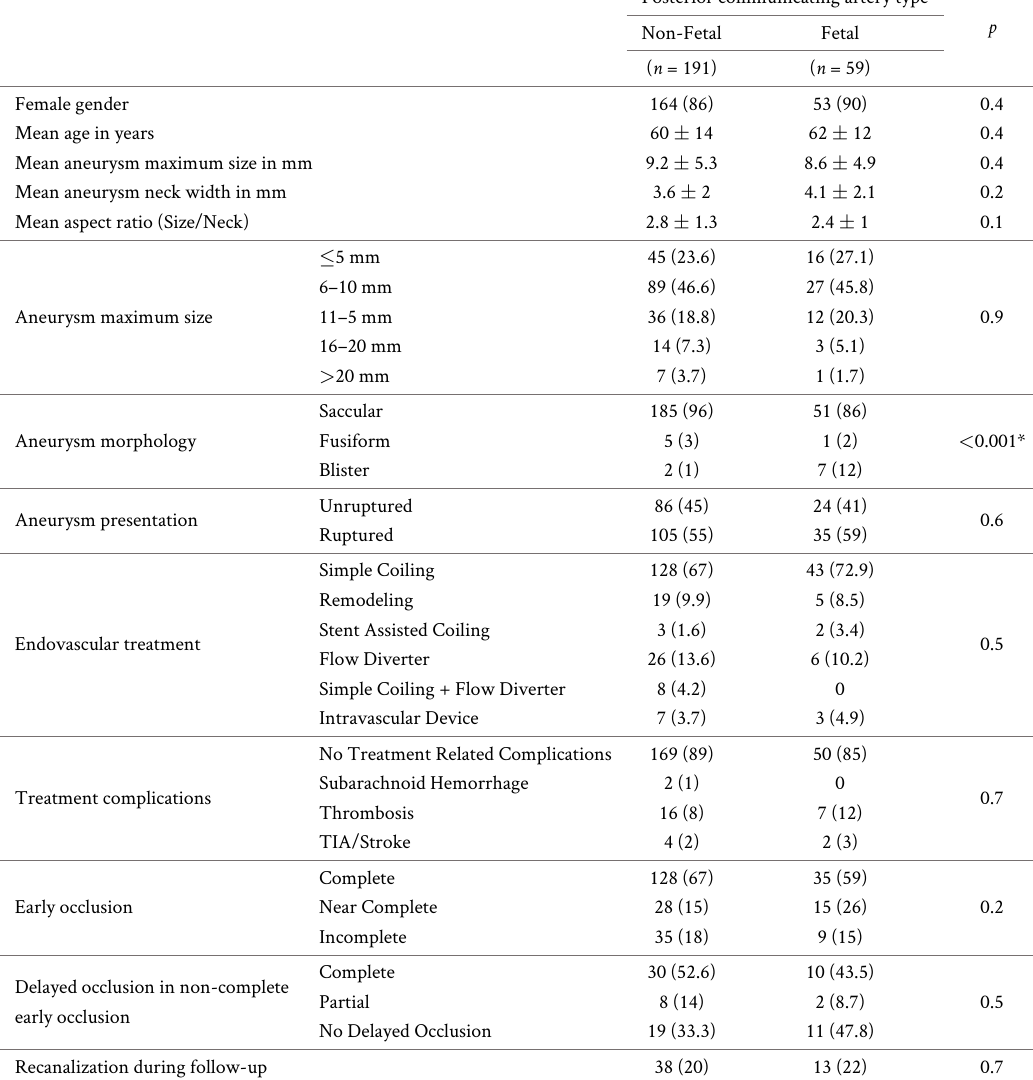
Table 6. Results according to posterior communicating artery